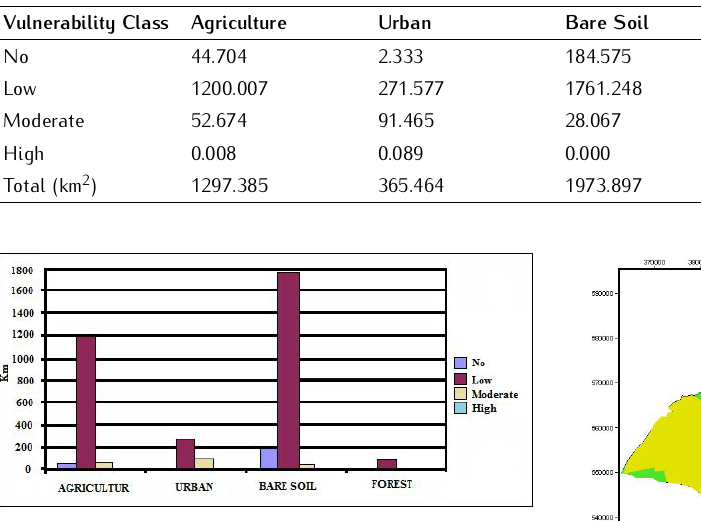
Table 10. Distribution of land use within the sensitive groundwater vulnerability.